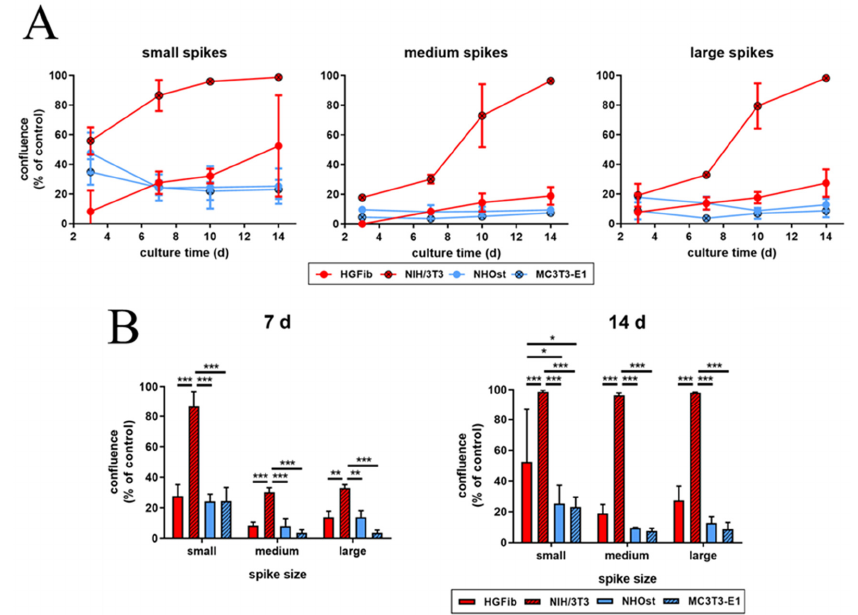
Figure 6. Cell migration of HGFib, NIH/3T3, NHOst, and MC3T3-E1 on spike topographies (direct comparison of the di ff erent cell type performances; for direct comparison of the di ff erent spike size e ff ects, see Supplementary Figure S8). Cells were cultivated on the spike structures for 3, 7, 10, and 14 days and stained with Calcein-AM. The overgrown area was measured and normalized to each control. The course over an observation period of 2 weeks ( A ) and significant di ff erences on day 7 and 14 ( B ) are presented. The mean values and standard deviation of three experiments are shown. Statistics were done by two-way-ANOVA (* p < 0.05, ** p < 0.01, *** p < 0.001). Int. J. Mol. Sci. 2020 , 21 , x FOR PEER REVIEW